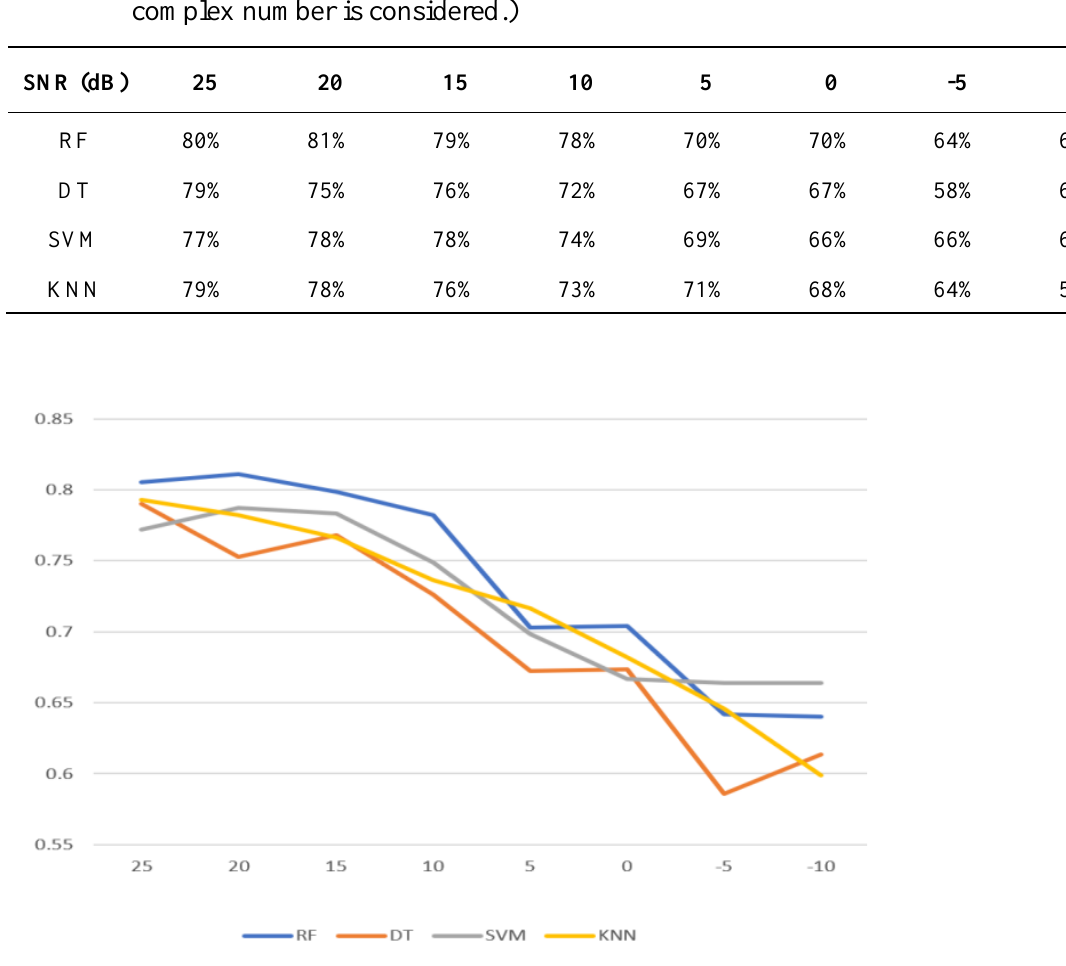
Figure 2. The Flow Diagram of Accuracy of Classification Methods Applying the Amplitude of samples considering their SNR